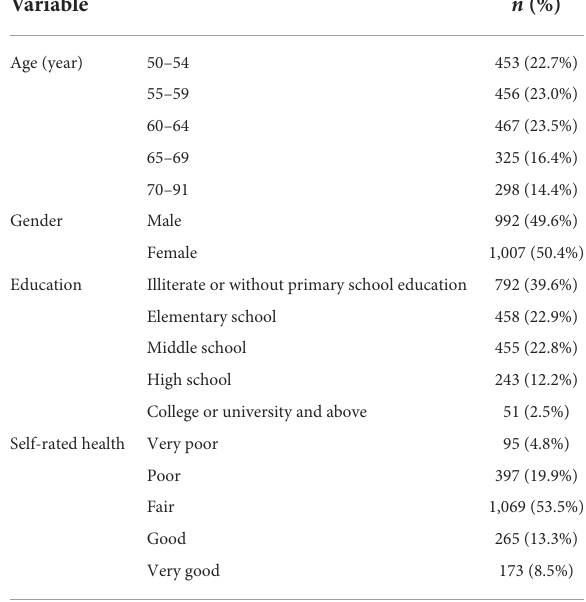
TABLE 1 Demographic characteristics of the participants at baseline ( N =